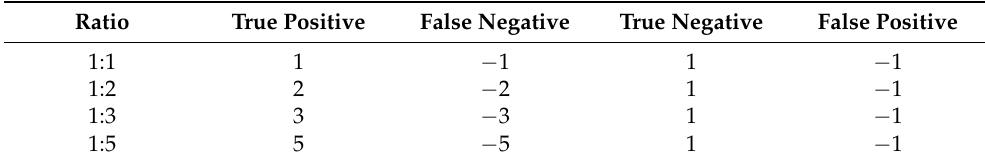
Table 2. Penalty/reward of the tested loss functions.